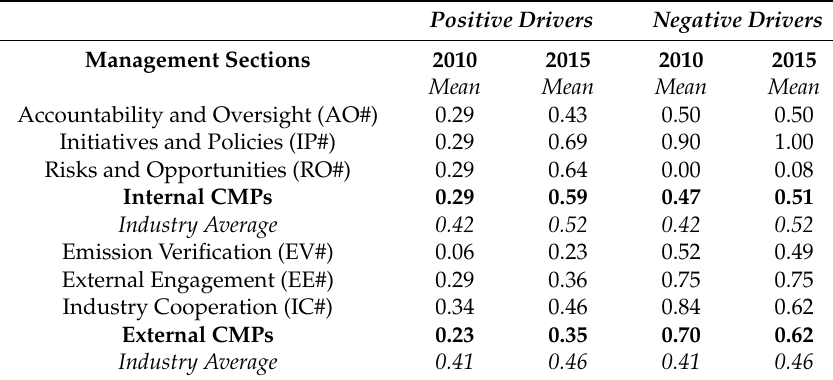
Table 3. Drivers for change in carbon disclosure